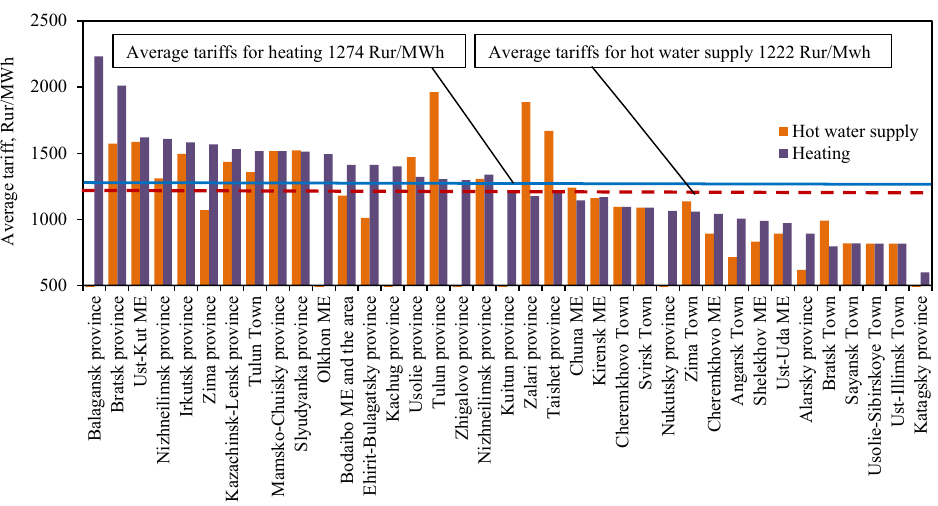
Fig. 2. Heat and hot water tariffs established by regulatory organizations for population of MU in the Irkutsk region.